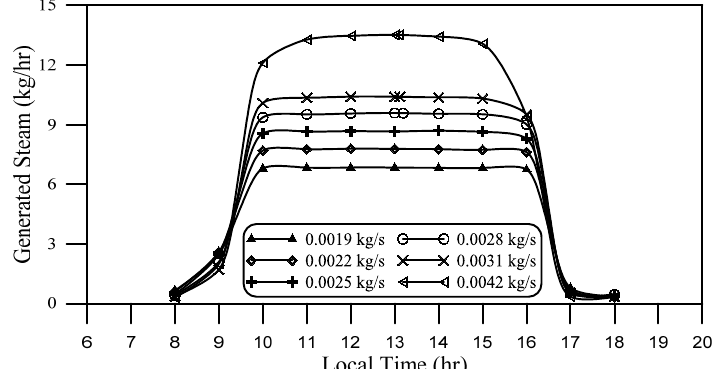
Figure 8. Daily profile of rate of generated steam mass for a 0.005 m diameter tube in a summer day.